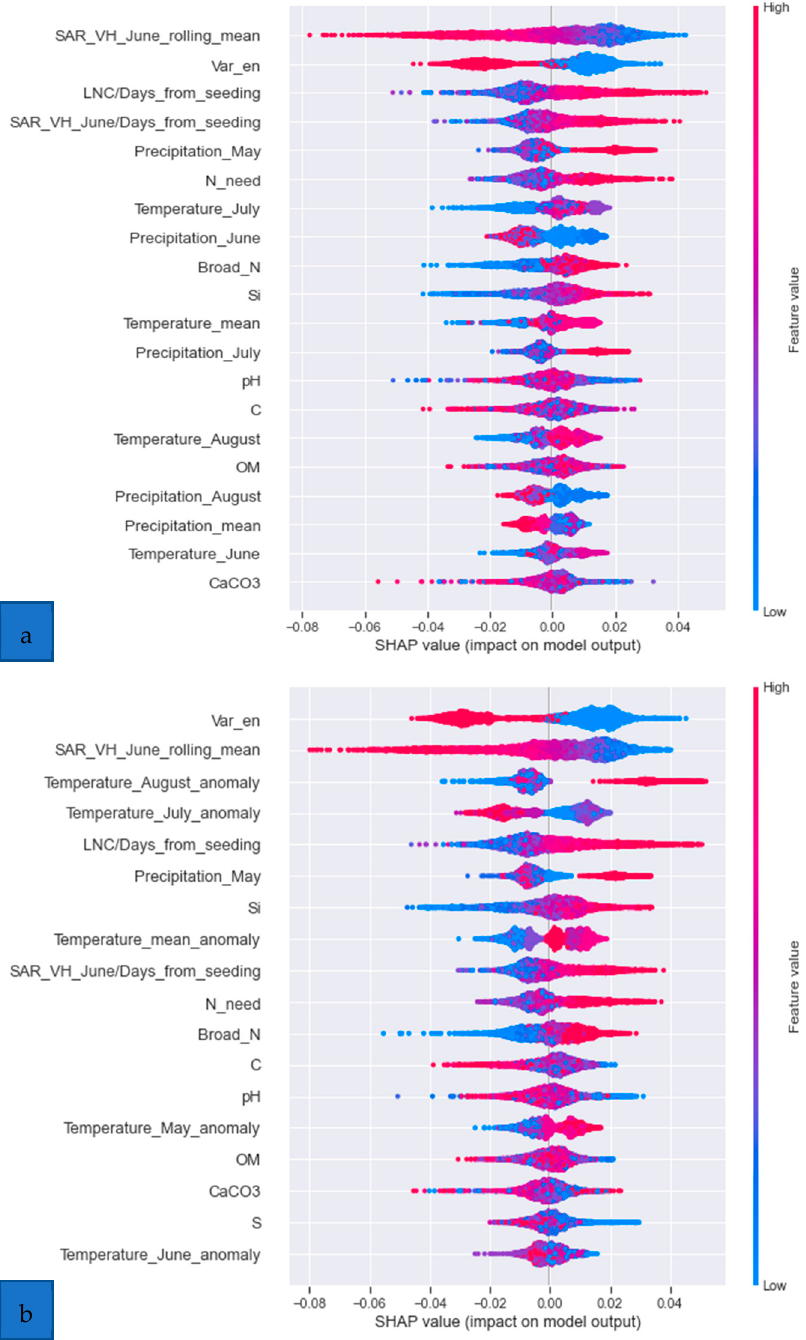
Figure 3. The results of feature evaluation using SHAP for feature importance of the CatBoost model using ( a ) hindcasts and ( b ) forecasts of climate data.